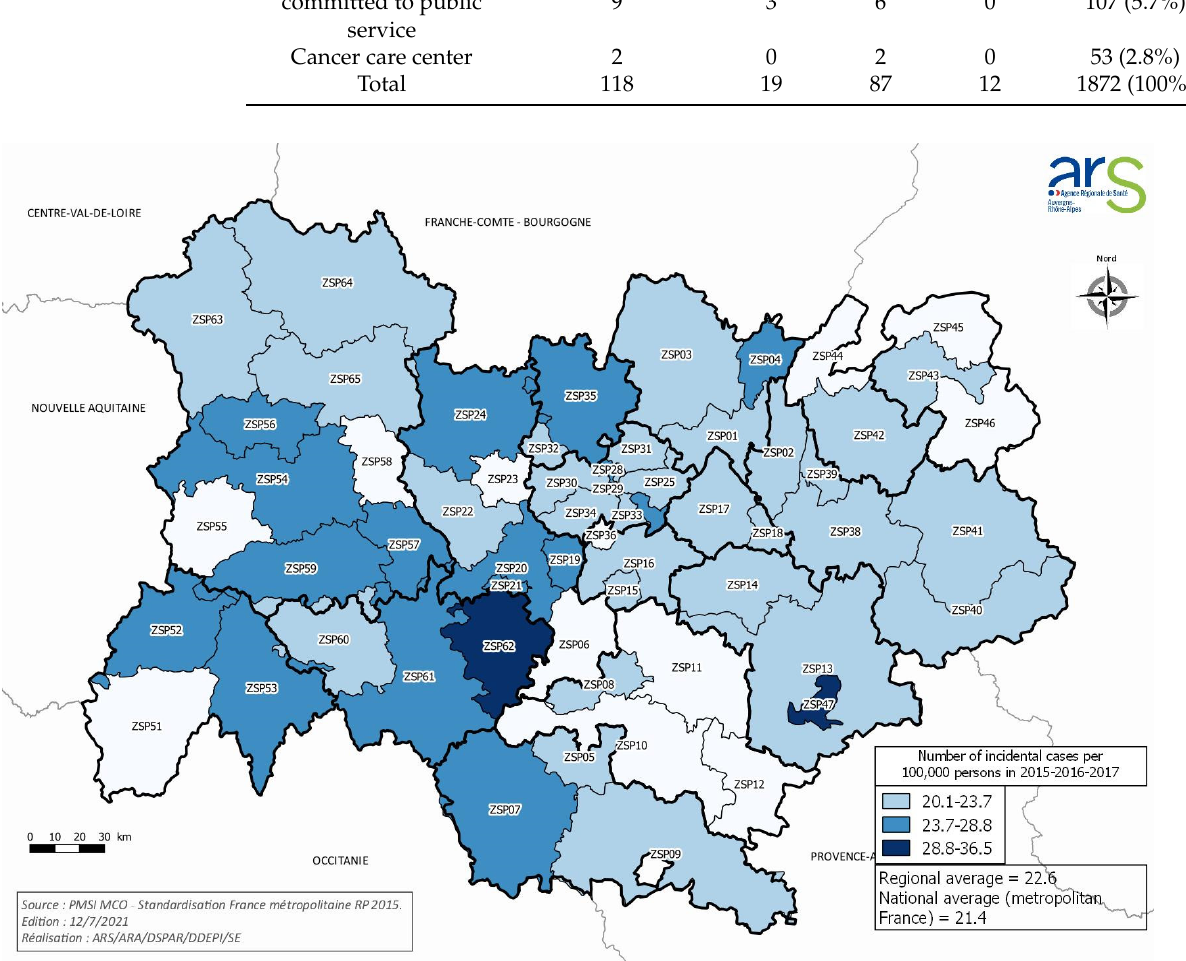
Figure 1. Pancreatic ductal adenocarcinoma (PDAC) in Auvergne-Rhône-Alpes, France in 2016: average annual incidence rates standardized by region of residence.